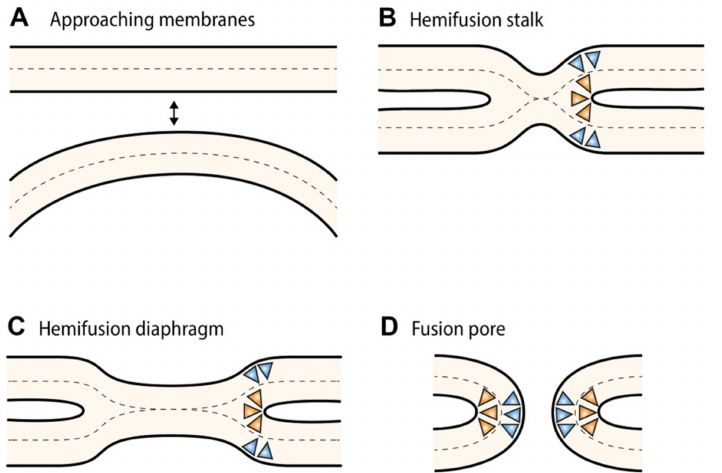
Figure 2. Stalk-pore model of membrane fusion. ( A ) Initial configuration with one membrane approaching the other membrane (or two membranes approaching each other). ( B ) Formation of the (hemifusion) stalk, in which the two proximal (i.e., contacting) monolayers have fused, but not the distal ones. ( C ) Radial expansion of the stalk structure results in the formation of the hemifusion diaphragm. ( D ) Perforation of the bilayer consisting of both distal leaflets leads to the final configuration of the fusion pore. The formation of highly curved fusion intermediates is promoted by the addition of negative-curvature-inducing factors (e.g., cone-shaped lipids, orange triangles) in the proximal (i.e., contacting) leaflets or positive curvature-inducing factors (e.g., amphiphilic helices or inverted cone-shaped lipids; blue triangles) in the distal leaflets. Adapted from